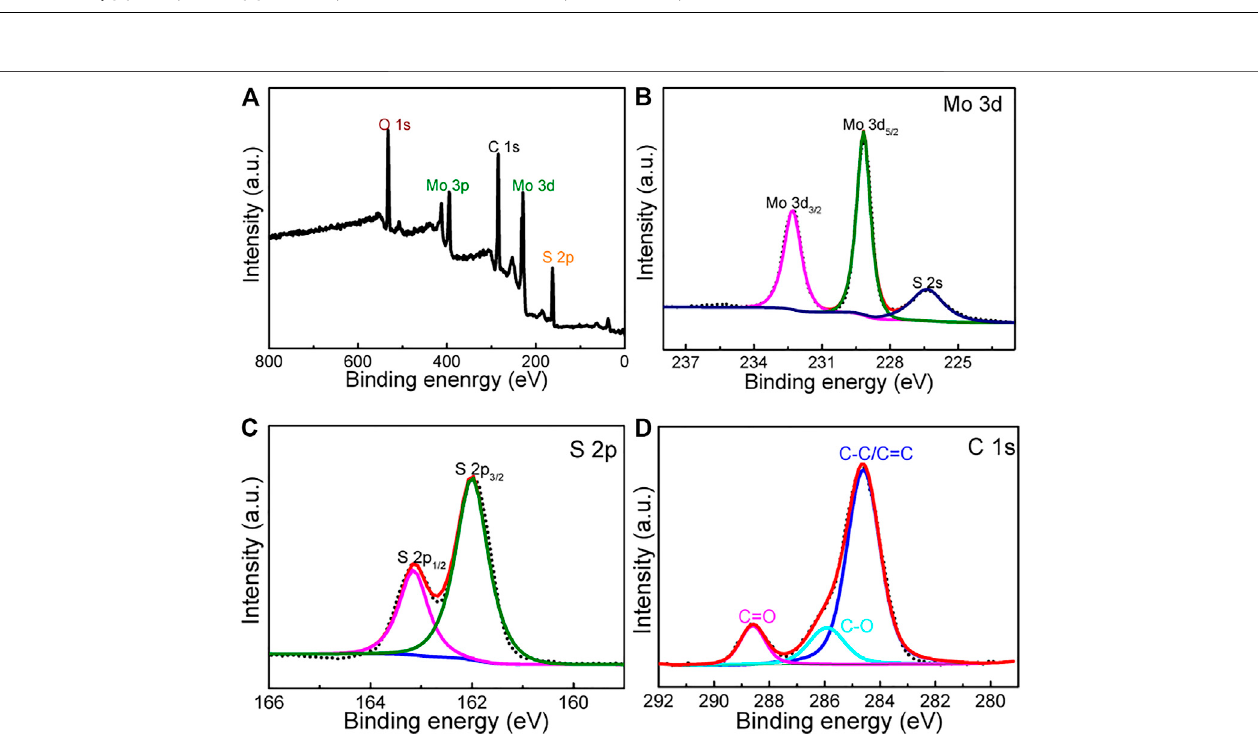
FIGURE 3 | (A) XPS survey spectrum of the composite. (B – D) High-resolution XPS spectra of (B) Mo 3d, (C) S 2p, and (D) C